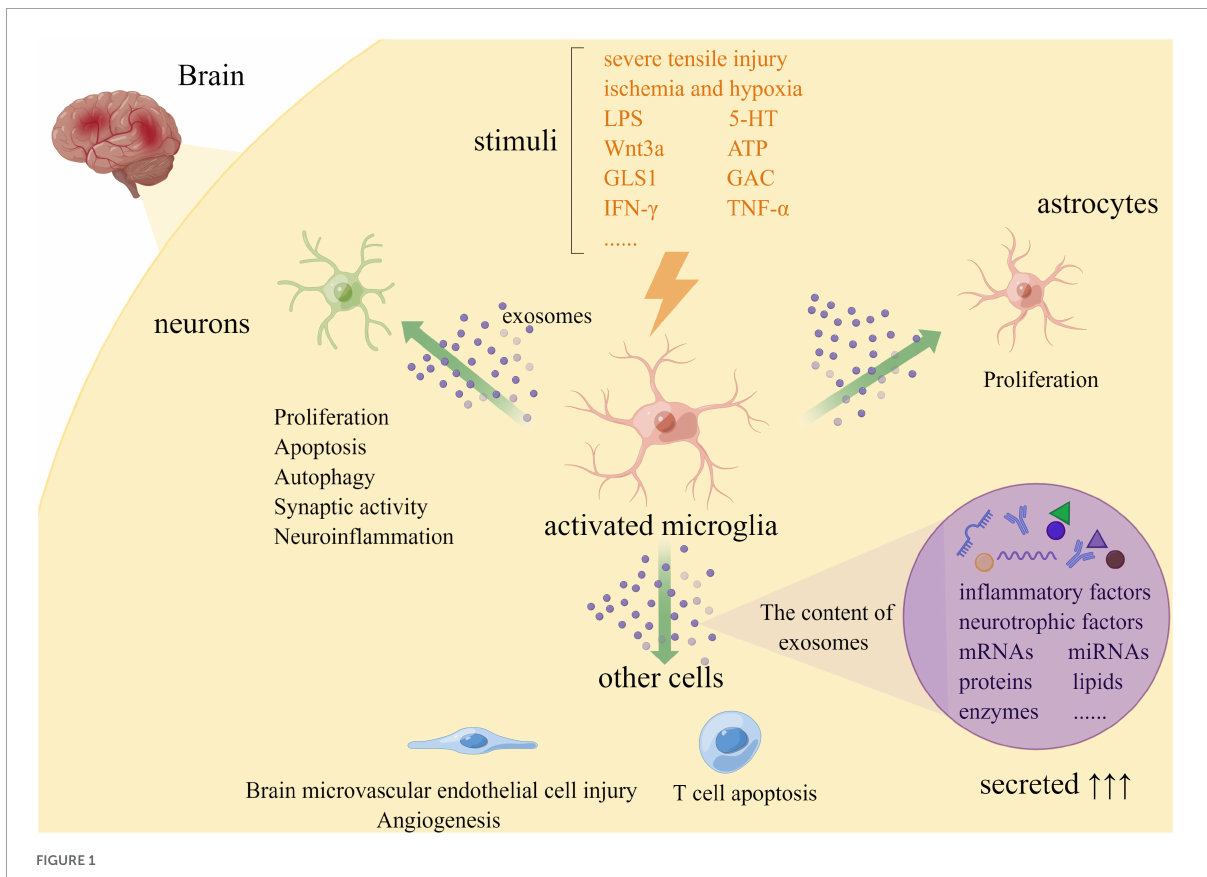
FIGURE1 Release and role of microglial exosomes in brain injury (By Figdraw.